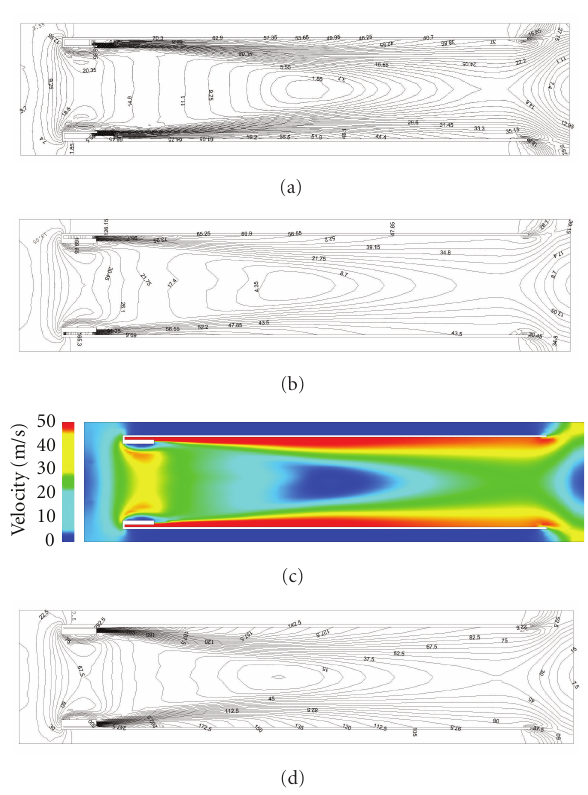
Figure 3: Isolines of the velocity V. (a) δ = 12 mm; (b) δ = 6 mm; (c) δ = 6mm; (d) δ =